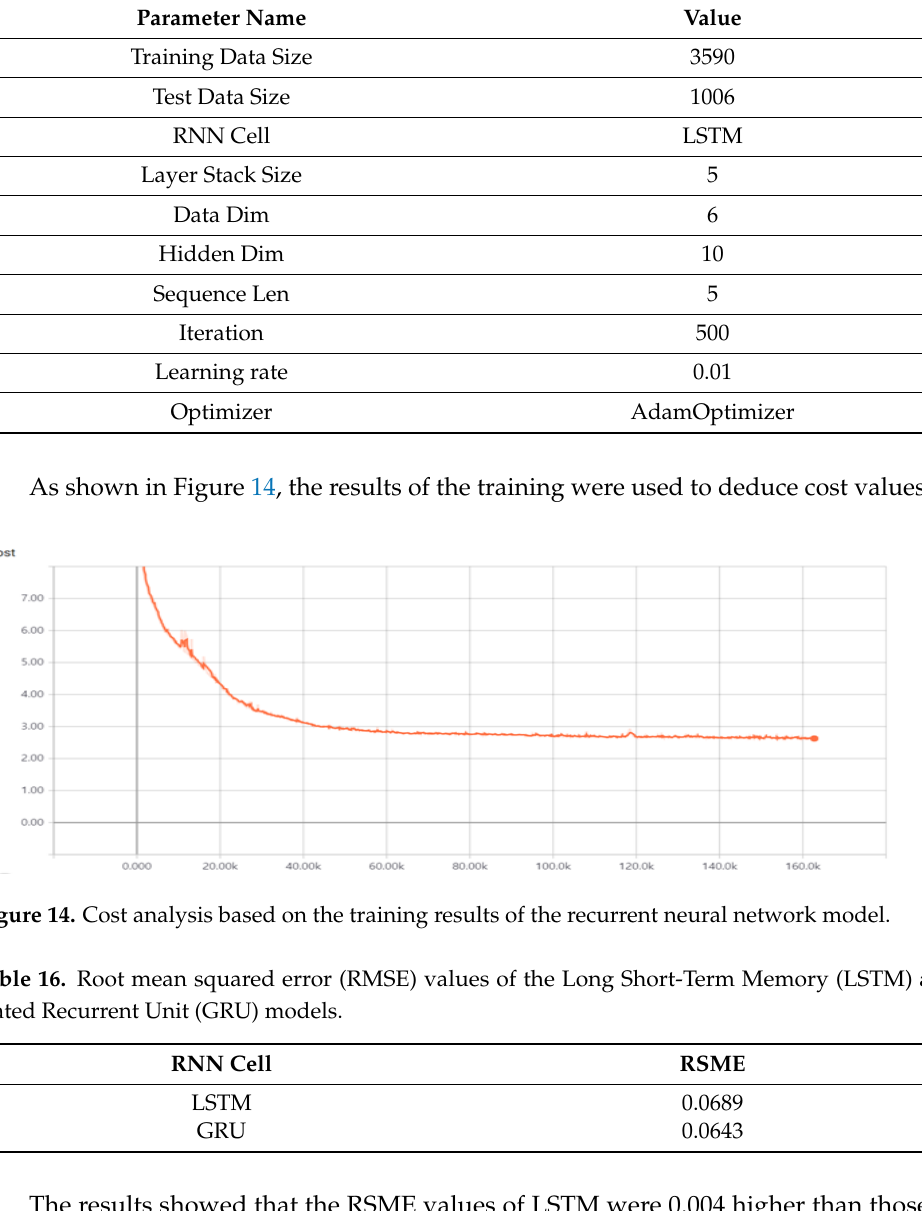
Table 15. Parameters defined to facilitate the training of the recurrent neural network model.